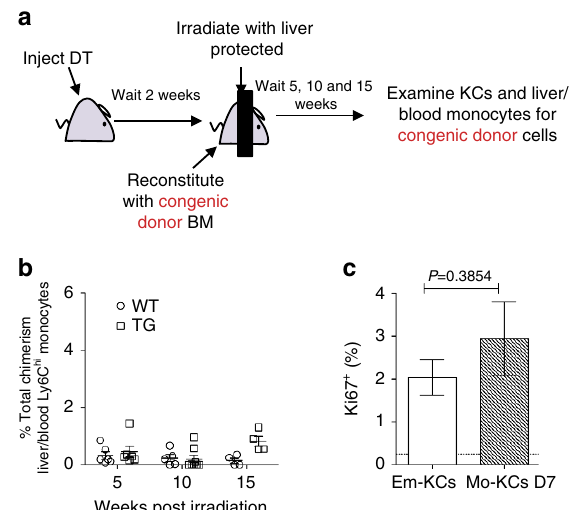
Figure 6 | Mo-KCs acquire the capacity to self-renew. ( a ) Schematic of shielded chimeras to determine lifespan of mo-KCs. ( b ) Percentage of total chimerism amongst KCs in fully depleted (50ng DT) KC-DTR (TG) and WT littermate controls. Chimerism amongst blood Ly6C hi monocytes was set at 100%. Data are pooled from two experiments. n ¼ 6 (WT and TG 5weeks), 5 (WT 10 weeks), 8 (TG 10 weeks) or 4 (WTand TG 15 weeks). ( c ) Percentage of Ki-67 þ em-KCs or mo-KCs at day 7 post administration of DT. Data are pooled from two experiments. n ¼ 6(em-KCs) and 7(mo-KCs). Dotted line represents FMO. P ¼ 0.3854, two-way Student’s t -test. Error bars represent